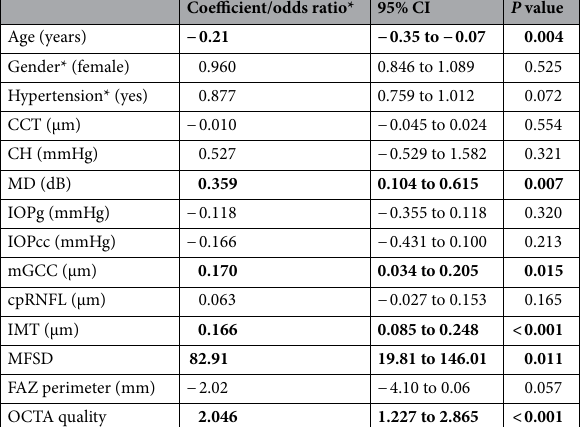
Table 3. Results of univariable regression analyses examine the relationship between pfVD and other variables. Values with a P -value < 0.05 are highlighted in bold.